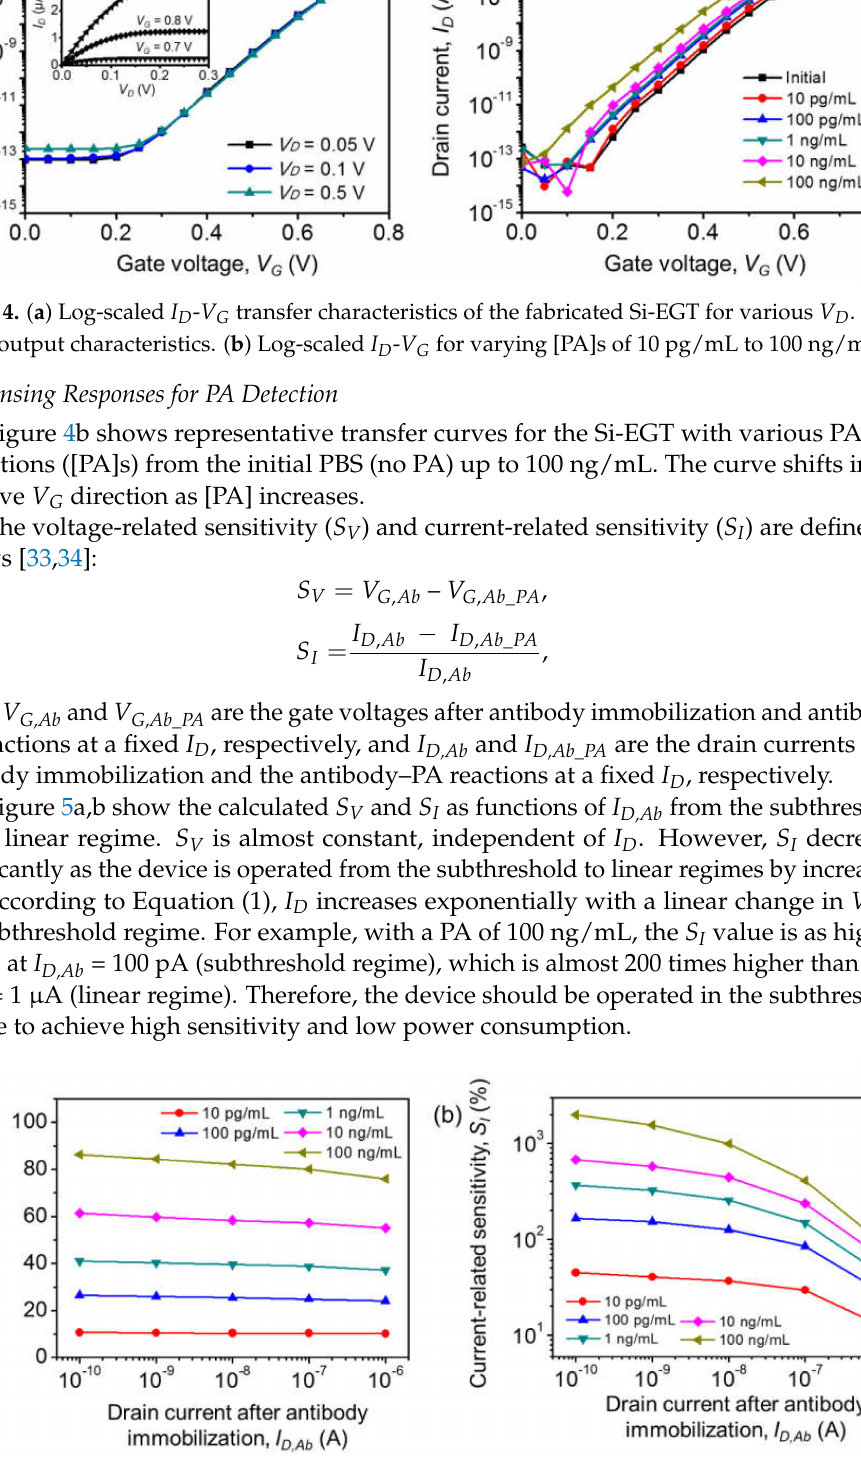
Figure 5. ( a ) Average voltage-related sensitivity S V and ( b ) average current-related sensitivity S I vs. I D,Ab of various